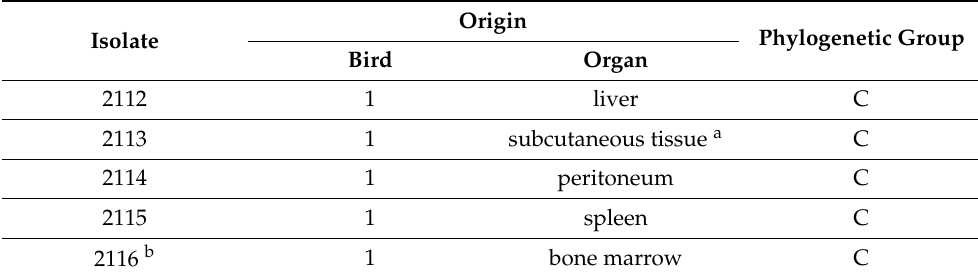
Table 1. Description of E. coli strains isolated from the daily mortalities.